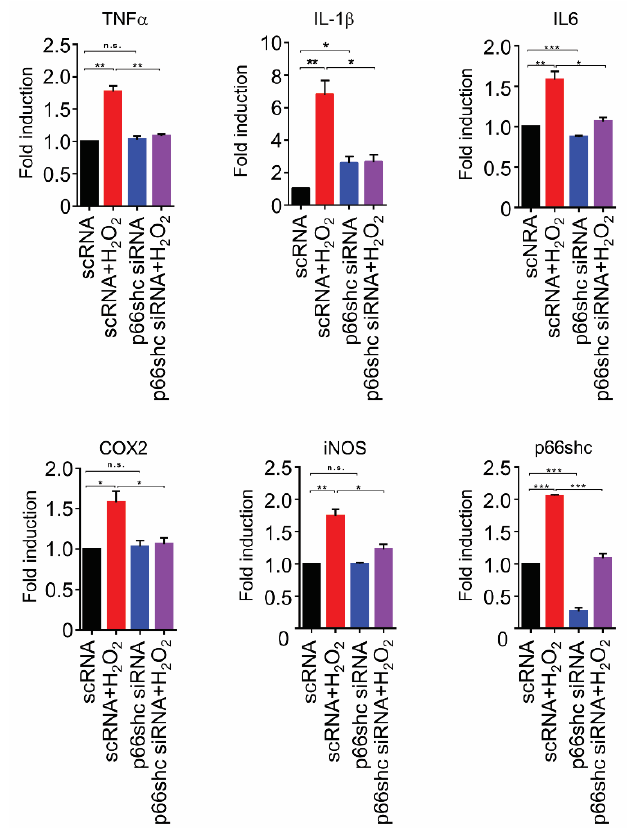
Figure 6. p66shc knockdown resulted in decreased mRNA levels of proinflammatory mediators in H 2 O 2 -induced HT22 cells. TNF- α : tumor necrosis factor- α , IL-1 β : interleukin-1 β , IL-6: interleukin-6, COX-2: cyclooxygenase-2, iNOS: inducible nitric oxide synthase. Data are expressed as means ± SEM (unpaired Student’s t -test, *** p < 0.001, ** p < 0.01, * p < 0.05).